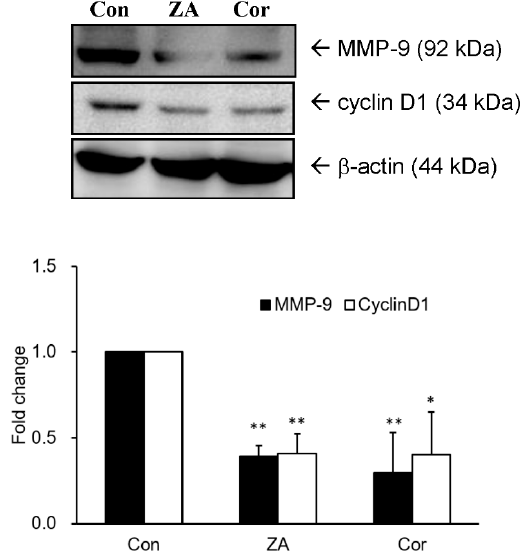
Figure 5. Effects of zhankuic acid A and cordycepin on the protein expressions of cyclin D1 and MMP-9 in A549 cells. The expression levels of cyclin D1 and MMP-9 were examined in A549 cells incubated with zhankuic acid A or cordycepin for 24 h. The band intensities of each group were quantified and normalized to the control group, and the relative expressions of gelatinases were presented as fold change in a histogram. * p < 0.05 and ** p < 0.01 compared to the control group (treated with vehicle alone), respectively. Con, control; ZA, zhankuic acid A; Cor, cordycepin.